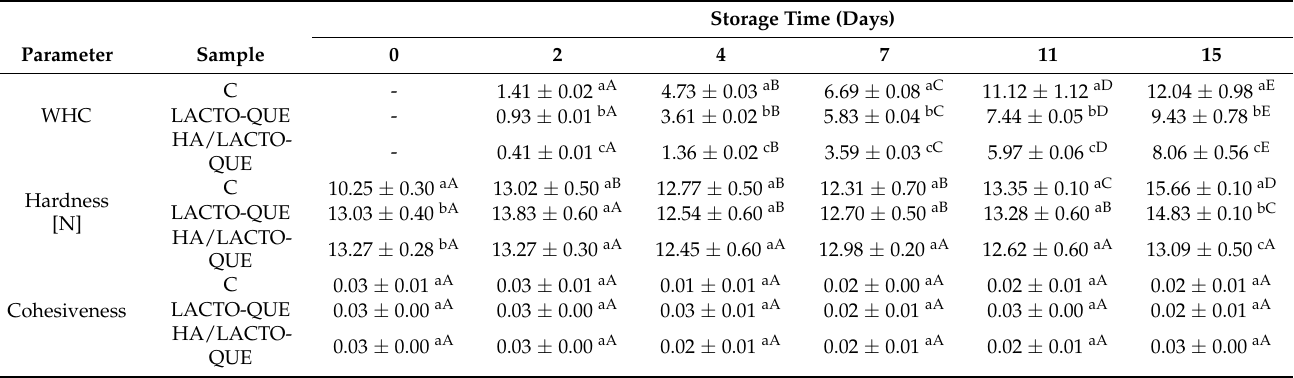
Table 3. Effects of alginate-based coatings on WHC and textural parameters of pork meat samples during the cold